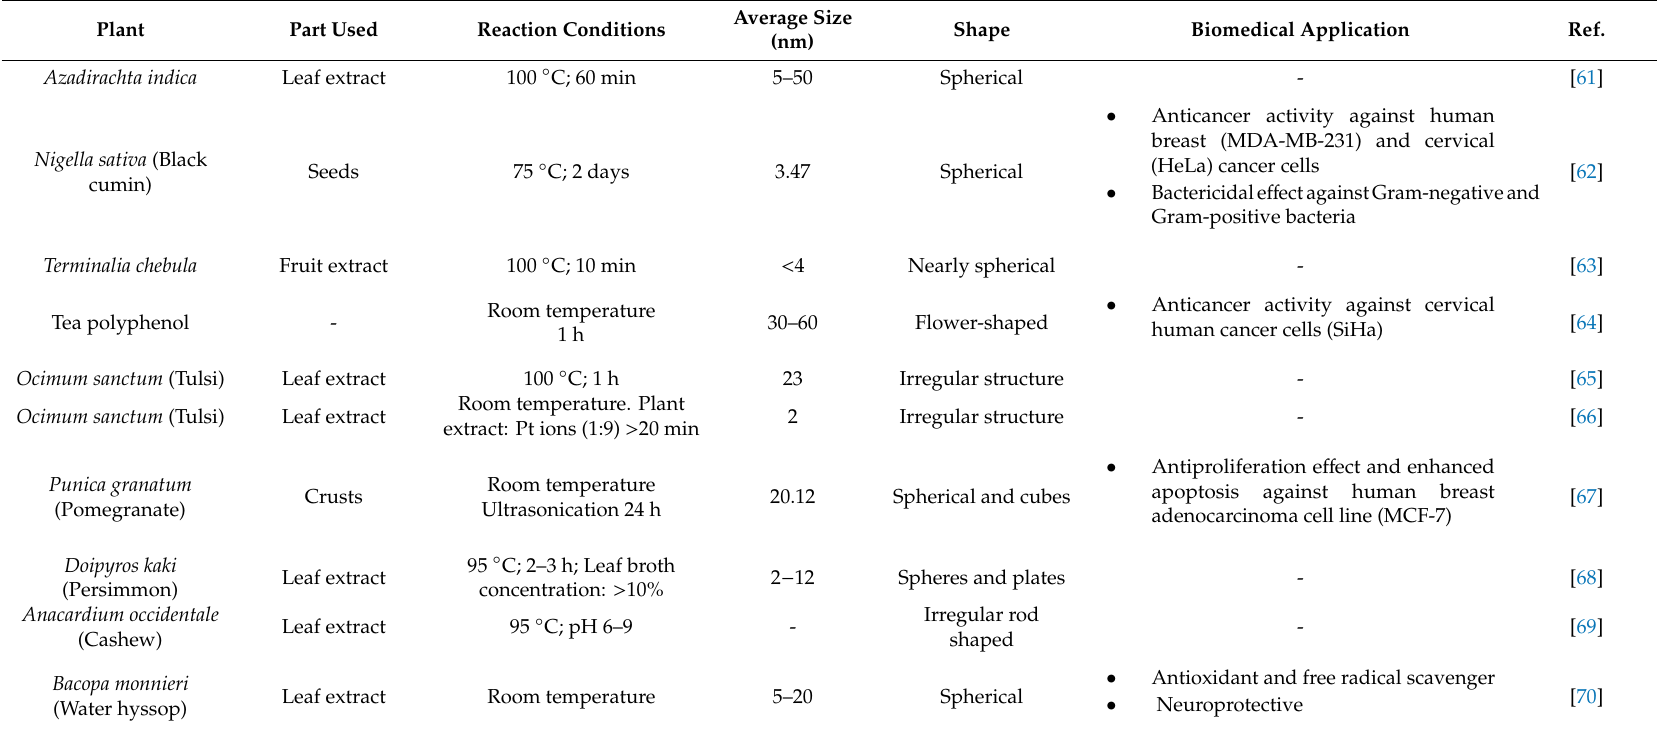
Table 1. Green synthesis of PtNPs using plant